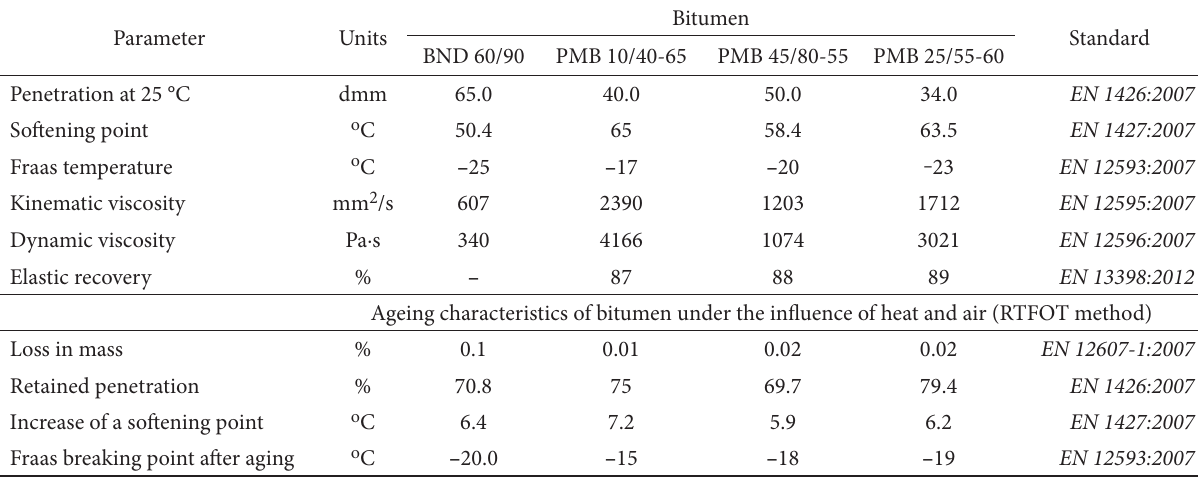
table 4. Typical characteristics of the bitumens